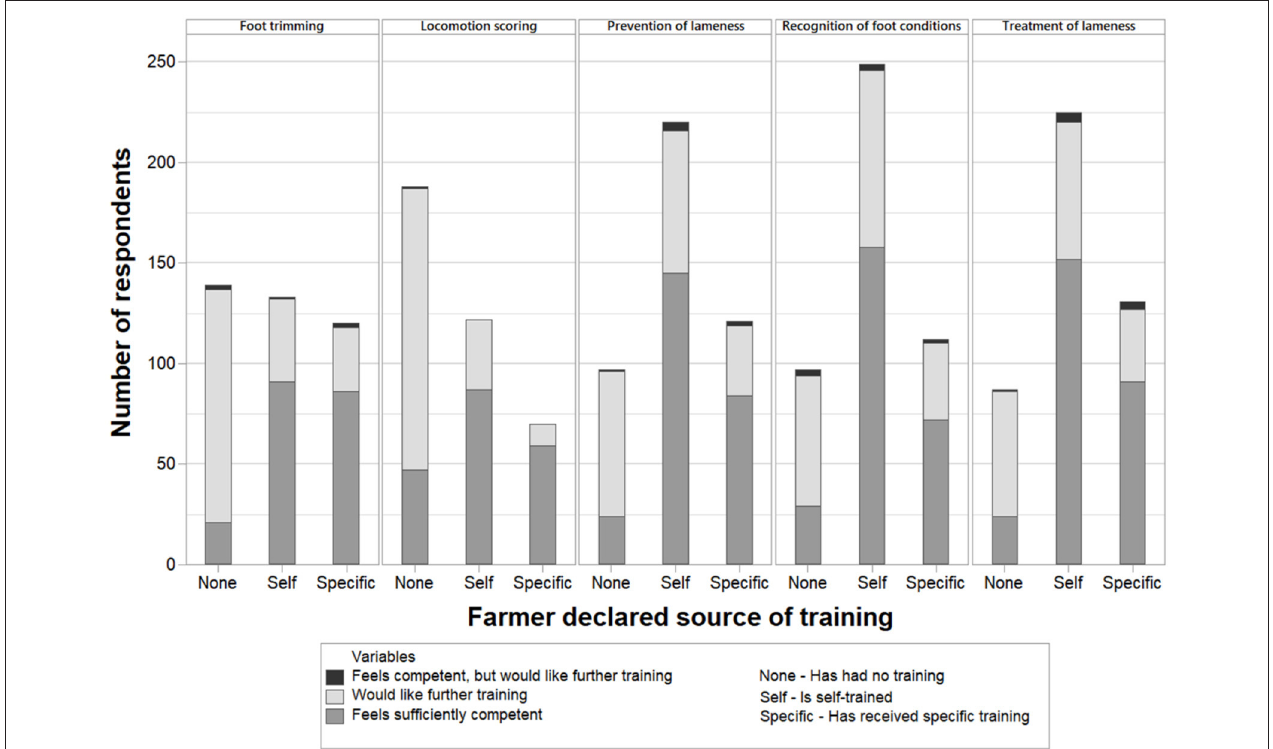
FIGURE 10 | Farmer self-reported source of training regarding five lameness topics, with corresponding declaration of either feeling sufficiently competent, wanting further training, or feeling competent but wanting more training. The five topics - shown from left to right - were: Foot trimming ( n = 392), Locomotion/mobility scoring ( n = 380), Prevention of lameness ( n = 438), Recognition of different foot conditions ( n = 458) and Treatment of lameness ( n = 443). As farmers could choose which questions to answer, the number of respondents differed between topics.